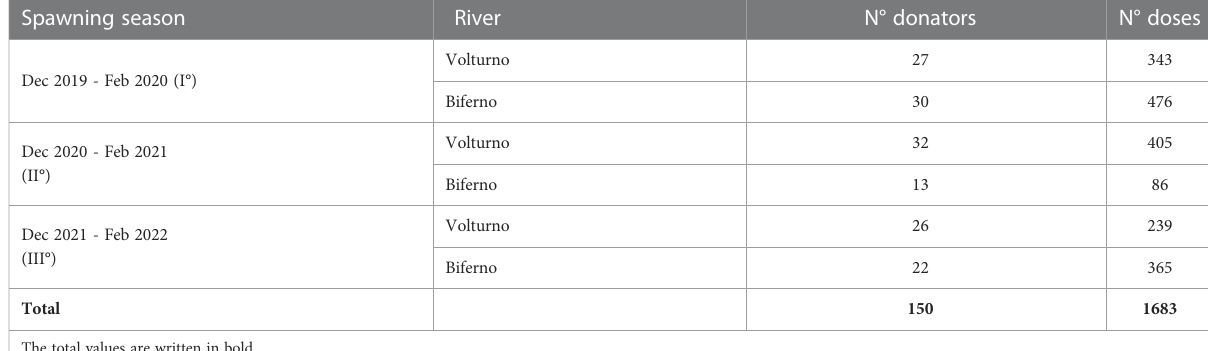
TABLE 1 Semen doses stored within the semen cryobank of Mediterranean brown trout during the project timeframe. Spawning season